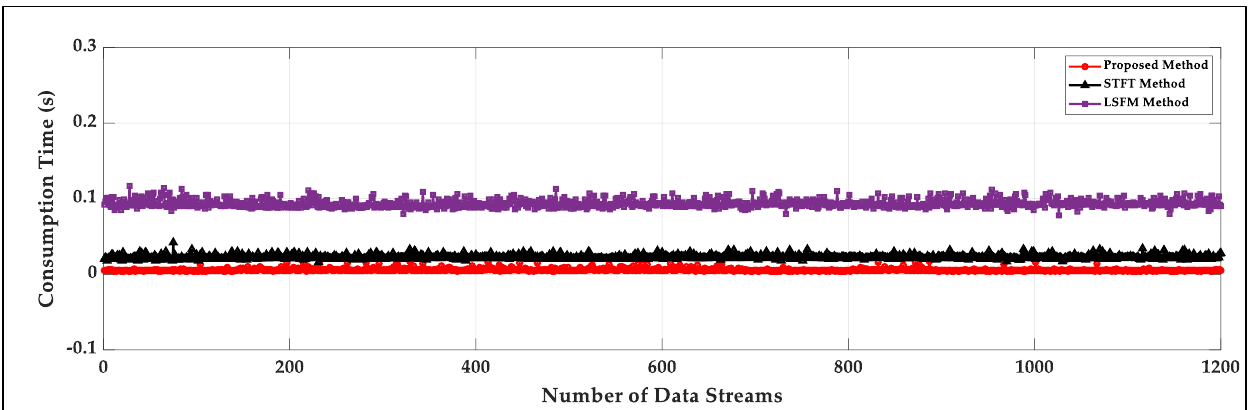
Figure 11. The consumption time of signal activity detection for the proposed method, the LSFM method and the STFT method.